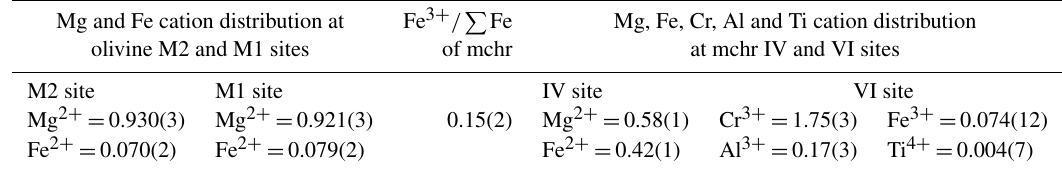
Table 3. Cation distribution at each crystallographic site for the touching olivine and mchr inclusion in the studied diamond. Mg and Fe cation distribution at Fe 3 + / (cid:80) Fe Mg, Fe, Cr, Al and Ti cation distribution olivine M2 and M1 sites of mchr at mchr IV and VI sites M2 site M1 site IV site VI site Mg 2 + = 0.930(3) Mg 2 + = 0.921(3) 0.15(2) Mg 2 + = 0.58(1) Cr 3 + = 1.75(3) Fe 3 + = 0.074(12) Fe 2 + = 0.070(2) Fe 2 + = 0.079(2) Fe 2 + = 0.42(1) Al 3 + = 0.17(3) Ti 4 + =